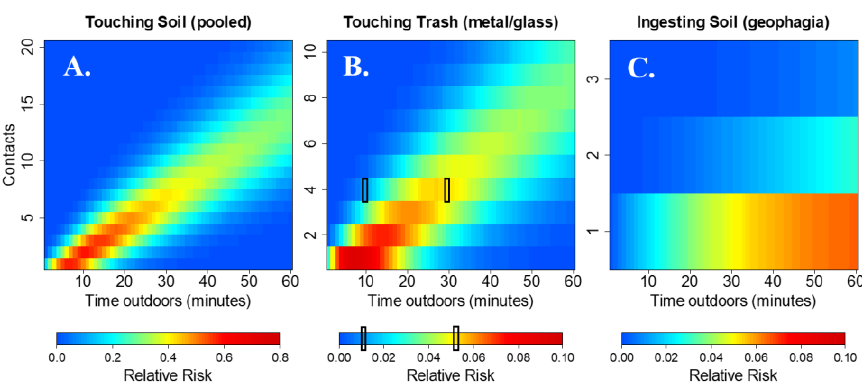
Figure 5. Temporal trends using the relative risk of engaging in one or more contacts compared to no contacts, as estimated from fitting the zero-inflated Poisson distribution. Each vertical slice represents the relative risk of a child engaging in a certain number of contacts (y-axis) compared to no contacts during play in a public area for a specific time-span (x-axis). For example, the probability of a child touching trash 4 times is less than 0.02 times the probability of never touching trash during 10 min of play at a public area (far-left black box in B ). During 30 min of play at a public area, the probability of touching trash 4 times increases to more than 0.05 times the probability of never touching trash (far-right black box in B ). Note the scale adjustment for the relative risk when comparing across figures.